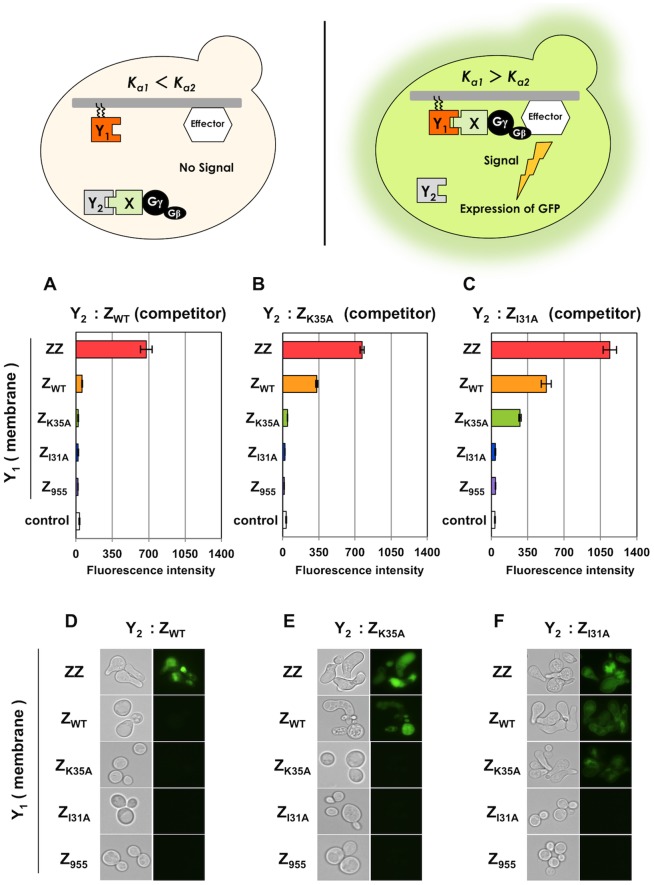

GFP transcription assays to test the selection of affinity-enhanced proteins.(A–C) Flow cytometry analyses. Fluorescence intensities of the engineered strains expressing cytosolic ZWT (A), ZK35A (B) and ZI31A (C) as the parental ‘Y2’ proteins. White bars indicate control yeast strains without the expression of ‘Y1’ (transformed with pGK413 mock vector). (D–F) Fluorescence microscope observations. Fluorescence micrographs of the engineered strains expressing cytosolic ZWT (D), ZK35A (E) and ZI31A (F) as the parental ‘Y2’ proteins. Five Z variants (ZZ, ZWT, ZK35A, ZI31A and Z955) were expressed as the membrane-anchored ‘Y1’ candidate proteins in each strain. To investigate transmission of the signal, 5 µM of α-factor was used for each strain. Standard errors of three independent experiments are shown.